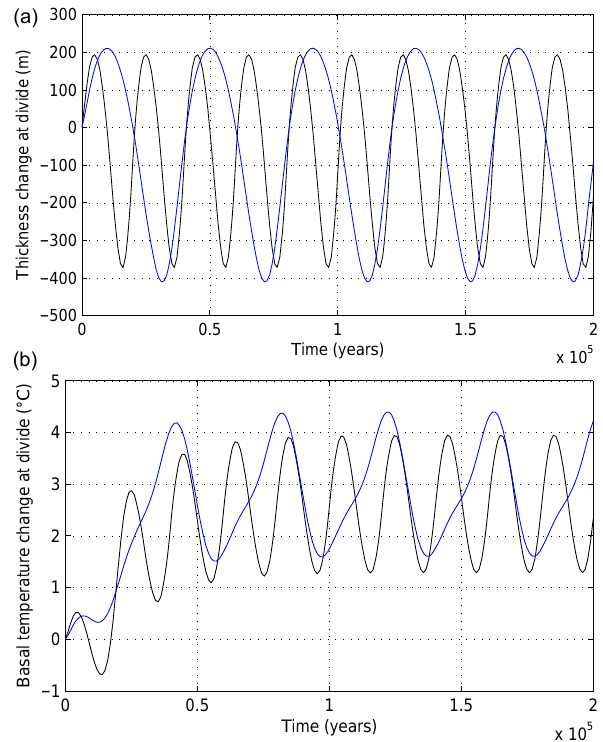
Figure A2. Ice thickness and basal temperature variations for the EISMINT-I fixed margin experiment with a 20ka (black) and a 40ka (blue)